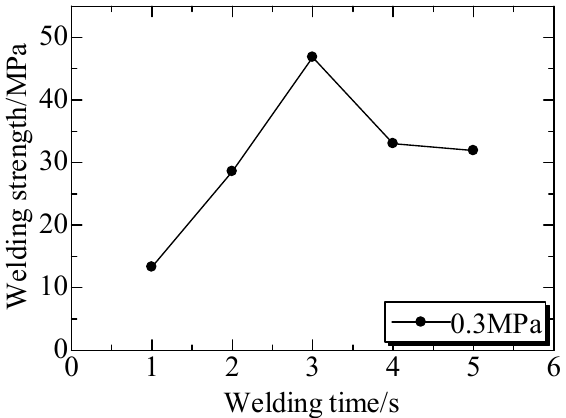
Figure 16. Welded strengths at different welding times under welding pressure of 0.3 MPa. Adapted from Reference [150].